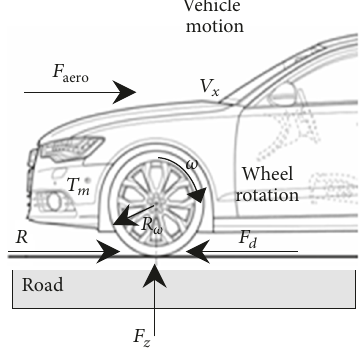
Figure 10: The quarter-vehicle